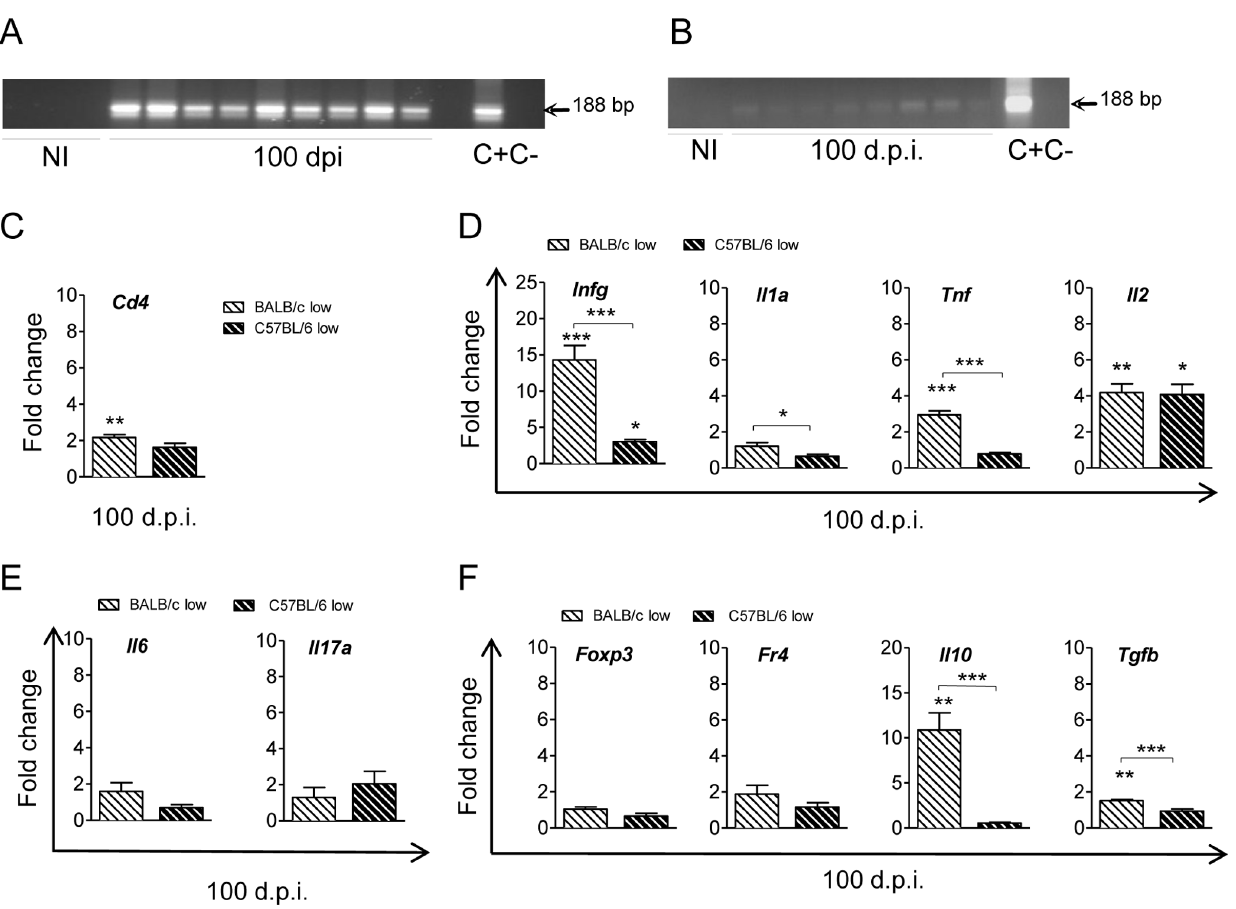
Figure 6. Infected BALB/c mice show a greater parasite load and more inflammation during the chronic phase than infected C57BL/ 6 mice. BALB/c and C57BL/6 mice were infected with the low inoculum and sacrificed at 100 d.p.i. ( A ) Specific T. cruzi PCR with DNA from the hearts of non-infected (NI) and infected BALB/c mice at 100 d.p.i.; parasite DNA was used as a positive control (C + ) and H 2 O as a negative control (C-). ( B ) As for ‘‘A’’ but for C57BL/6 mice. Quantitative RT-PCR from total heart tissue RNA of infected BALB/c mice (open dashed bars) and C57BL/6 mice (filled dashed bars) utilizing: ( C ) a Cd4 probe, ( D ) Ifng, Il1a, Tnf and Il2 probes, ( E ) Il6 and Il17a probes and ( F ) Foxp3 , Fr4 , Il10 and Tgfb probes. Data represent the results of at least two independent experiments performed with 3 mice per experimental group and were normalized with respect to NI mice (Fold change: 1). Statistically significant differences between infected and non-infected mice and between BALB/c and C57BL/6 mice under each treatment are shown: * p , 0.05,** p , 0.01 and *** p ,